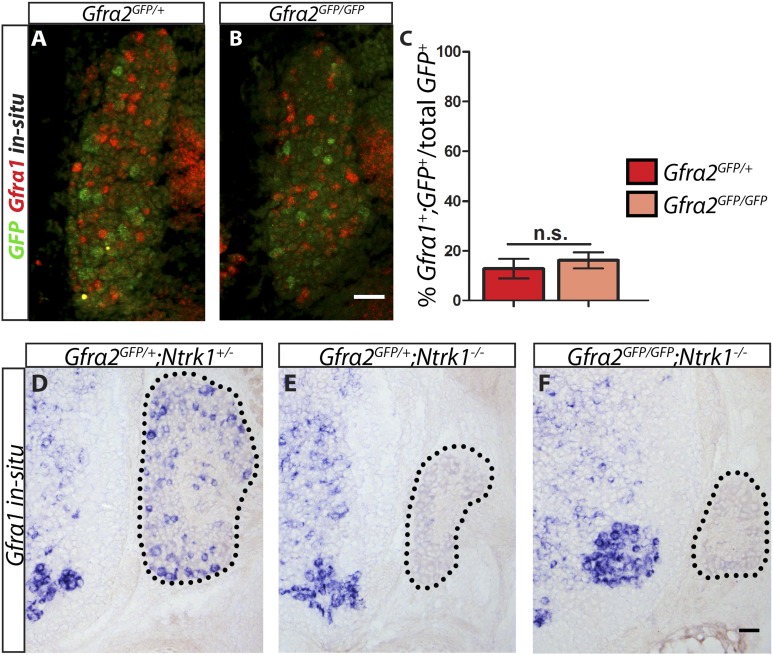
Gfra1 is not upregulated in Gfra2 null RA mechanoreceptors.(A–B) Double fluorescent in situ hybridization against GFP and Gfra1 on E14.5 Gfra2GFP/+ control (A) and Gfra2GFP/GFP null (B) DRG sections. (C) Quantification of percentage of GFP+ neurons which co-express Gfra1. 12.81 ± 3.92% of control GFP+ neurons express Gfra1, and 16.17 ± 3.31% of Gfra2 null GFP+ neurons express Gfra1 (p = 0.52). The comparable low number of DRG neurons co-expressing GFP and Gfra1 in control and Gfra2 nulls suggests that Gfra1 normally is not expressed in most RA mechanoreceptors and that no upregulation of Gfra1 occurs in Gfra2 null RA mechanoreceptors. (D–F) In situ hybridization against Gfra1 in P0 Gfra2GFP/+;Ntrk1+/− control (D), Gfra2GFP/+;Ntrk1−/− null (E), and Gfra2GFP/GFP;Ntrk1−/− double null (F) DRG and SC sections. Black border outlines DRG. In control DRG sections, Gfra1 is expressed in some DRG neurons. In Gfra2GFP/+;Ntrk1−/− null DRG sections, Gfra1 transcript is not detected because the DRG neurons which normally express detectable levels of Gfra1 don't survive in the absence of Ntrk1. In Gfra2;Ntrk1 double null mice, no Gfra1 expression is detected in DRG neurons as well, which further supports that upregulation of Gfra1 doesn't occur in Gfra2 null RA mechanoreceptors. Scale bars = 50 μm. Error bars represent SEM. n.s. = p > 0.05.DOI:
http://dx.doi.org/10.7554/eLife.06828.01710.7554/eLife.06828.018Figure 6—source data 1.QPCR of Gfra1 in embryonic Gfra2 null DRGs.